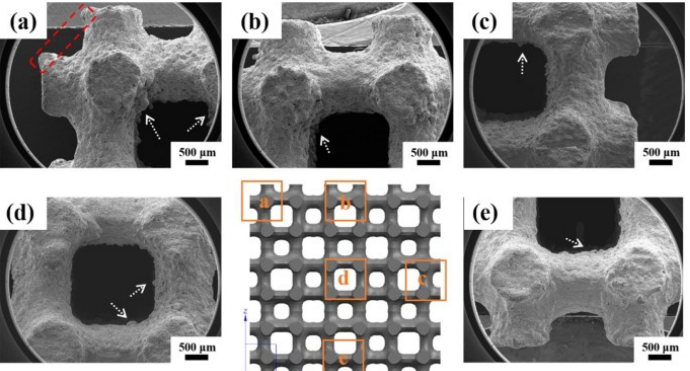
Figure 29. Cross-section of optimized lattice design printed using SLM with Ti-6Al-4V powder. The bottom middle panel displays the pattern geometry with two alternating periodic spacings. The remaining panels ( a – e ) respectively show labelled and magnified images of the lattice in the microscale, where the scale bar is 500 μ m [148]. (Reprinted from Journal of Manufacturing Processes, Volume 56, L. Zhang, et al., ‘Topology-optimized lattice structures with simultaneously high stiffness and light weight fabricated by selective laser melting: Design, manufacturing and characterization’, Pages 1166-1177, Copyright (2020), with permission from Elsevier).